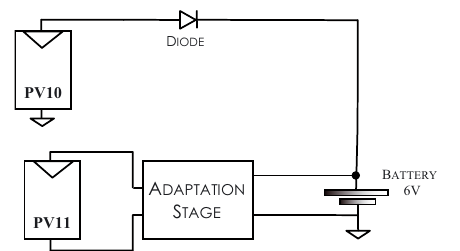
Fig. 16. Block diagram of the experimental set-up used to characterize the photovoltaic conversion chains.